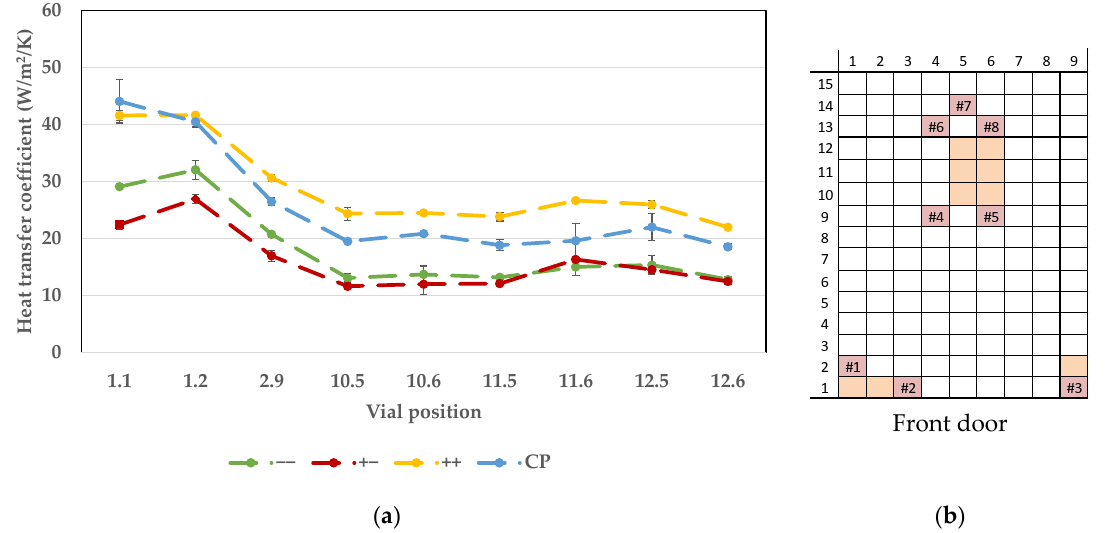
Figure A1. Position-specific values of K V . Figure A1. The heat transfer coefficient of each vial. ( a ) Position-specific values of K V ; ( b ) Vial position and